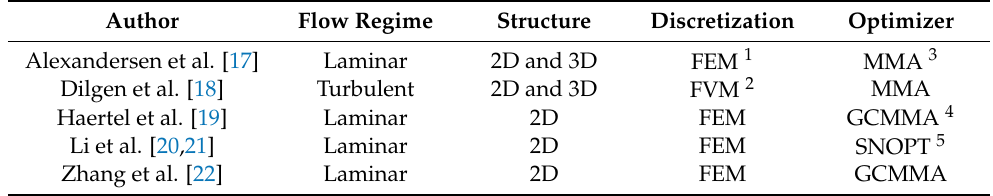
Table 1. An overview of density-based topology optimization in recent studies on thermofluid